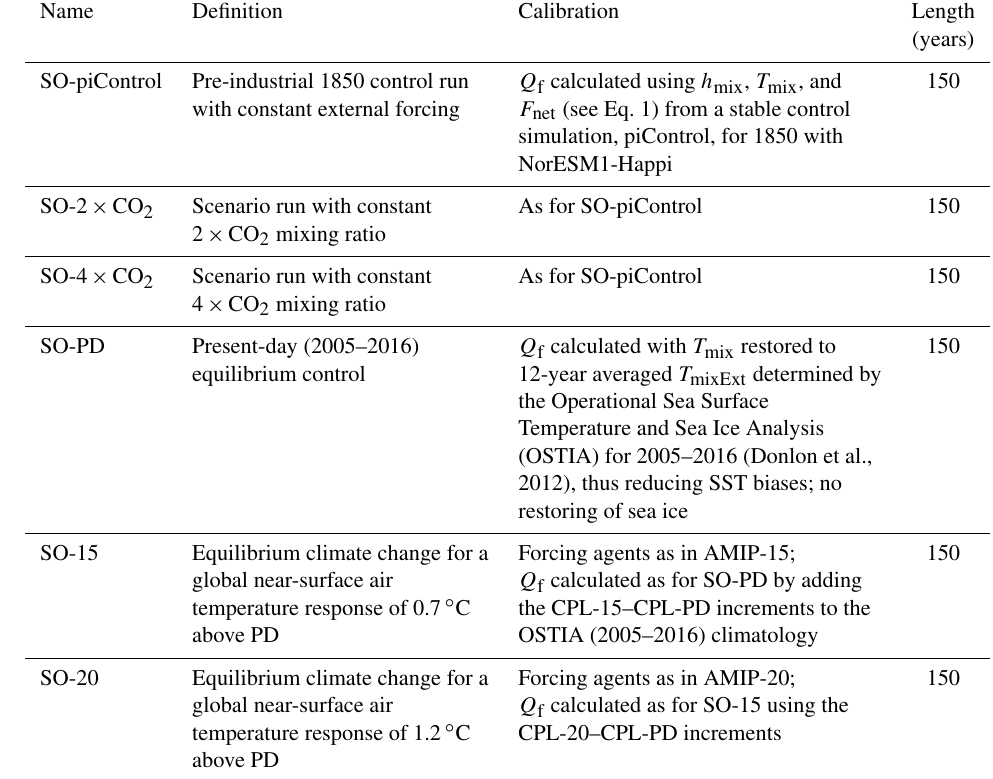
Table 2. Overview of the NorESM1-HappiSO experiments and their calibration. Q f is the net divergence of heat not accounted for by the explicit processes, which is needed to maintain a stable climate with a predefined geographical distribution of SST. In SO-PD, SO-15, and SO-20, a restoring term − ( T mix − T mixExt ) /τ is included in Q f , where τ = 30d is the applied timescale of adjustment. Notice that sea ice is not restored except for via the indirect effect of the SST restoring